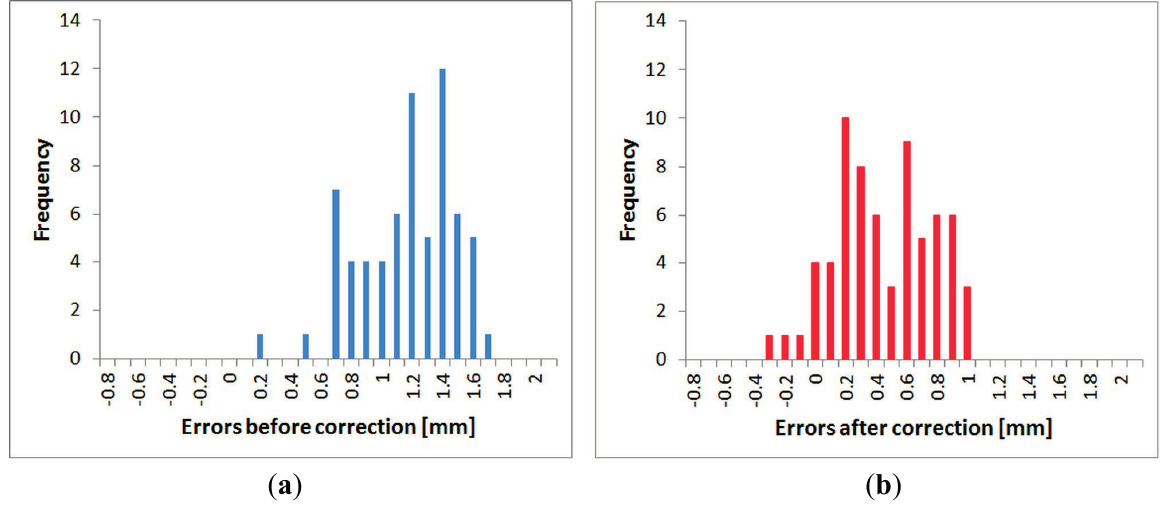
Figure 38. Distribution of the errors–Trimble S6: ( a ) before the correction; ( b ) after the correction.